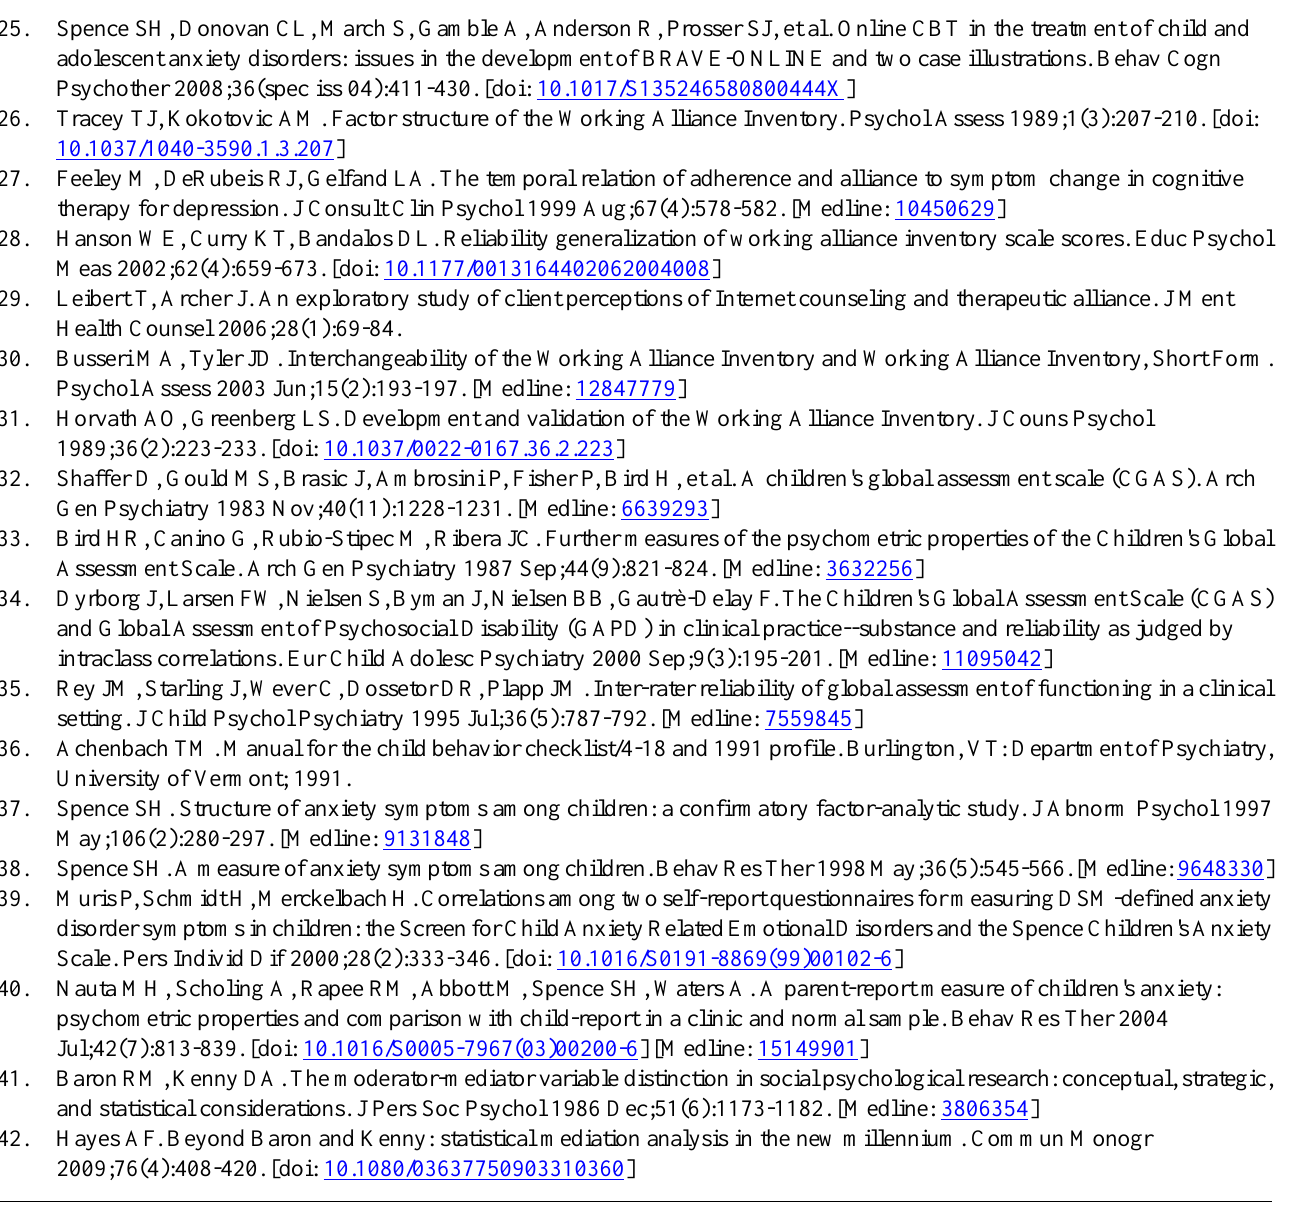
CGAS: Children’s Global Assessment Scale DSM-IV-TR: Diagnostic and Statistical Manual of Mental Disorders, fourth edition, text revision SCAS-C: Spence Children’s Anxiety Scale-Child Version SCAS-P: Spence Children’s Anxiety Scale-Parent Version WAI-S: Working Alliance Inventory-Short